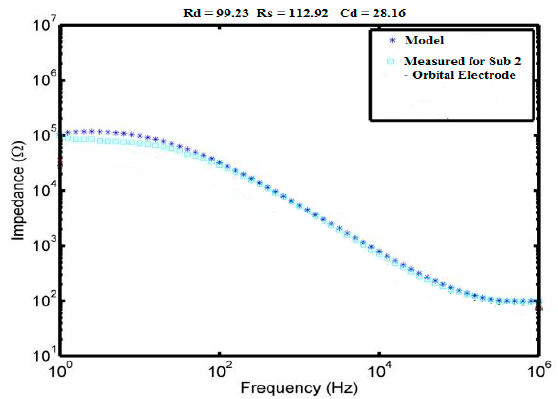
Figure 7. Experimental results for Orbital electrode-skin impedance frequency response (Subject, Orbital-S2) and the model plot. Estimated electrode circuit components values are located at the top of the Figure.